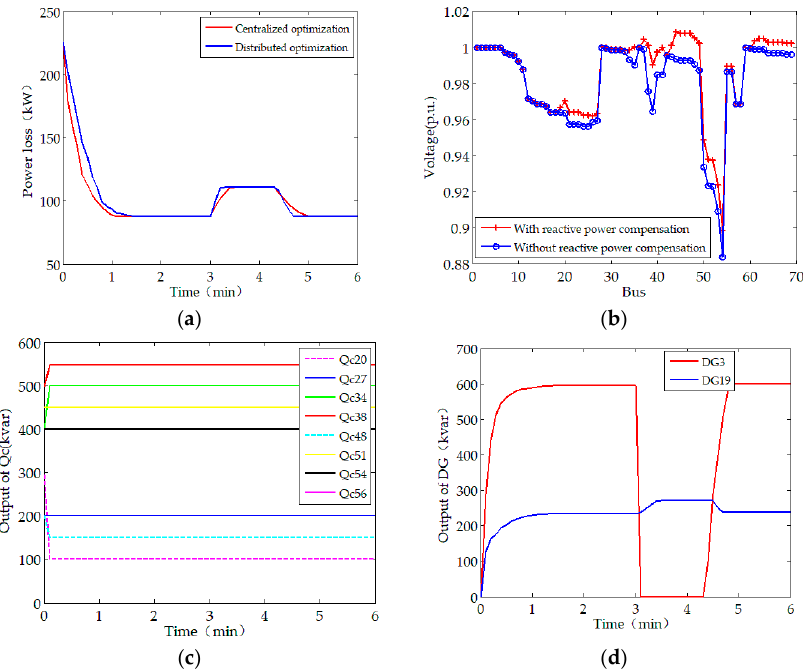
Figure 8. The optimized dispatch scheme under Scenario C: ( a ) Evolution of the objective function; ( b ) Voltage profiles with and without the distributed optimization solution; ( c ) Capacitor bank control sequences; ( d ) Output of DGs.